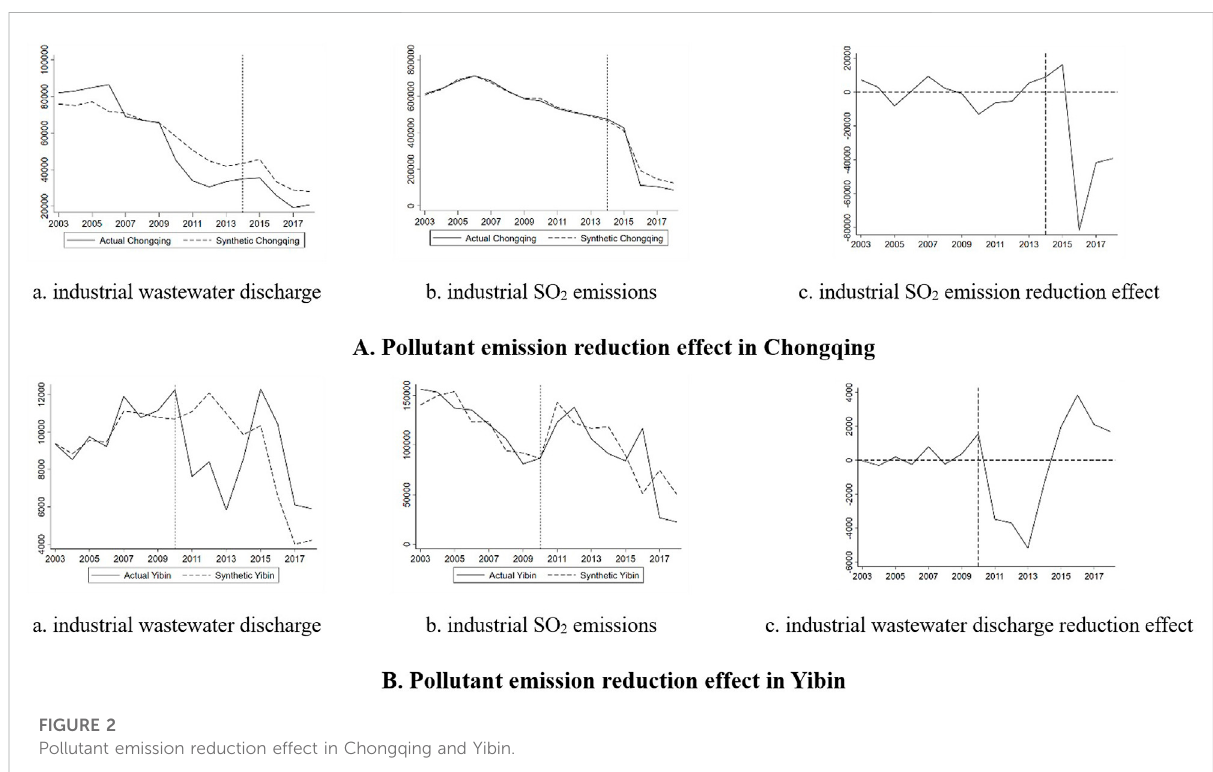
FIGURE 2 Pollutant emission reduction effect in Chongqing and